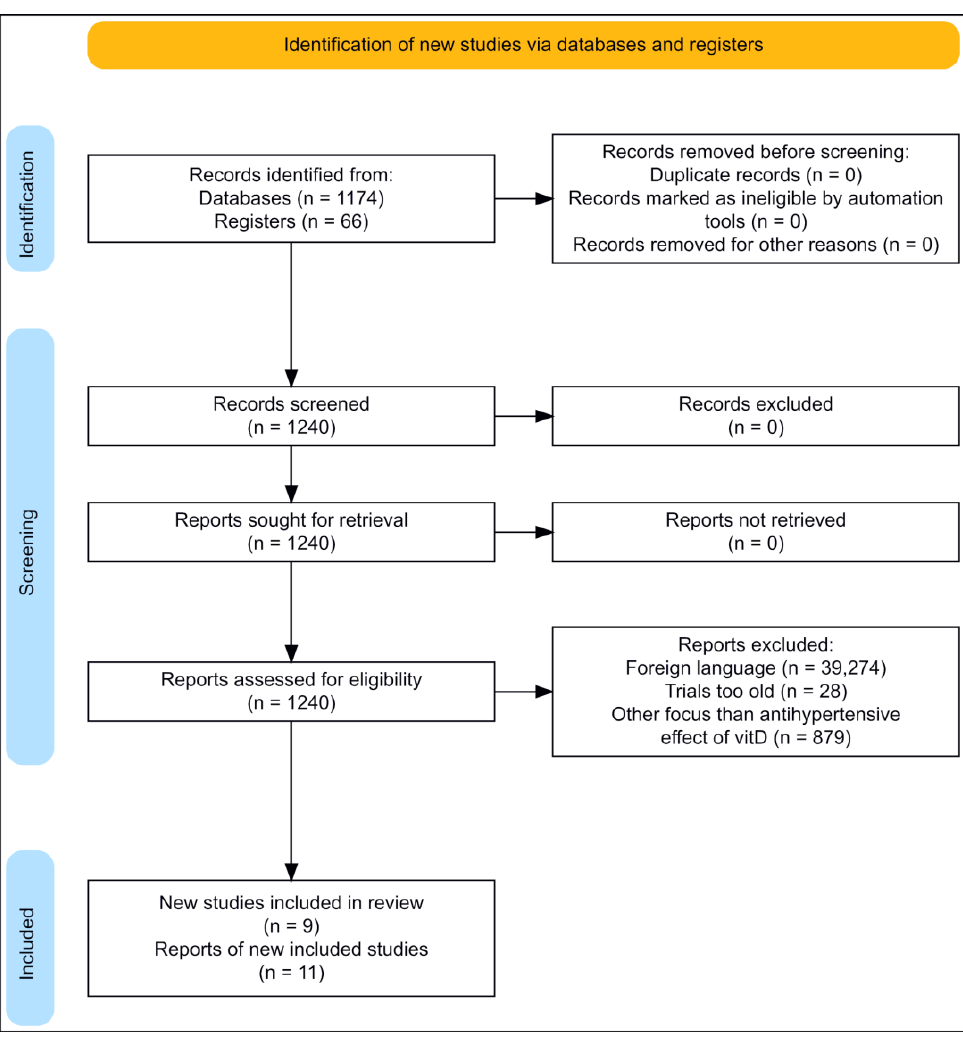
Figure 2. Flow diagram of the literature searched for this review. (Made with https://estech.shinyapps.io/prisma_flowdiagram/, accessed on 11 December 2022).